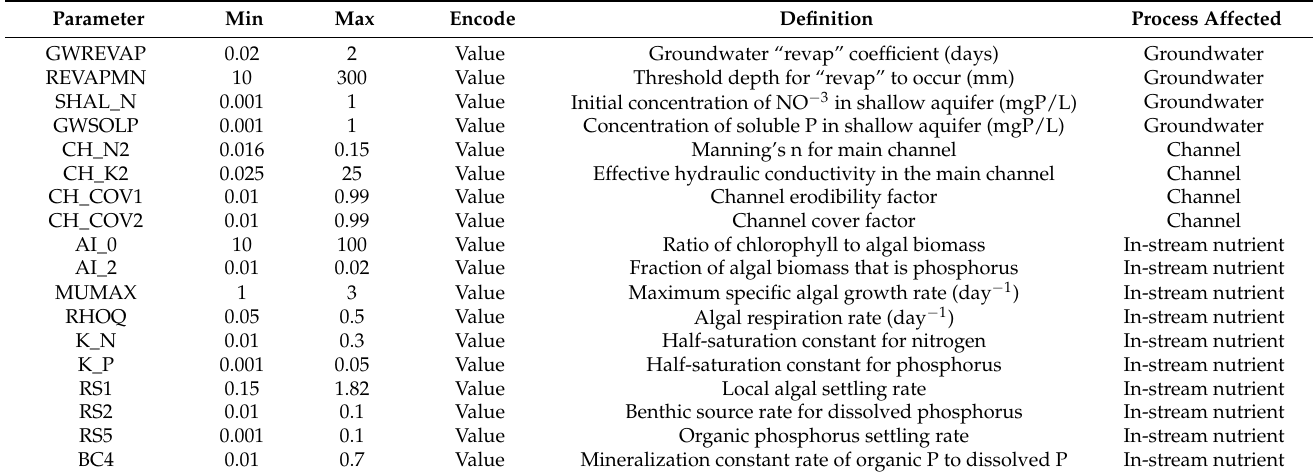
Table 1. Some of the optimized parameters determined from the sensitivity